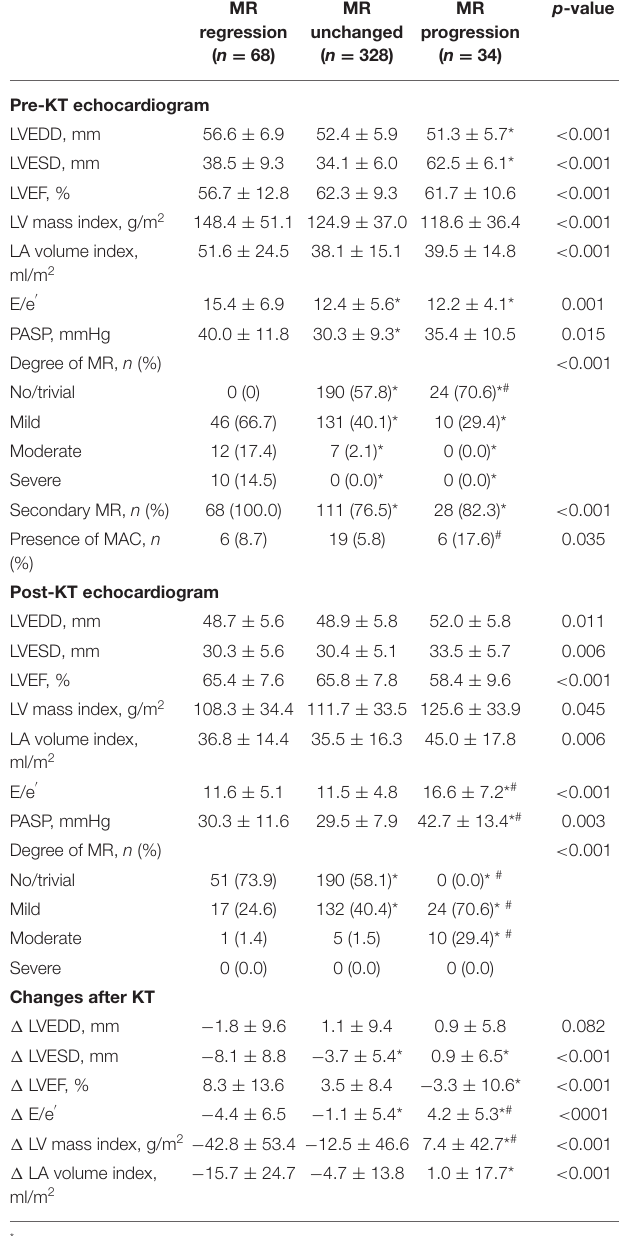
TABLE 1 | Comparison of clinical and renal characteristics in the three groups according to change in mitral regurgitation. MR regression